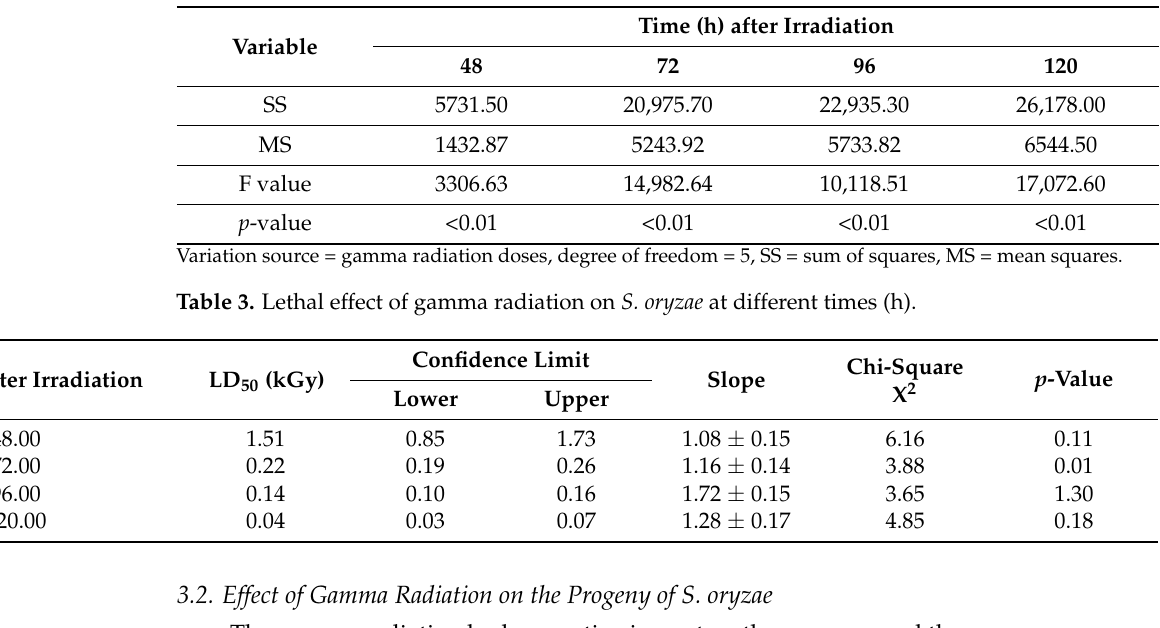
Values are the mean ± S.E. The means of each column followed by the different letters are significantly different at 0.05 level according to Tukey’s multiple range test. Table 2. Analysis of variance of mortality percentage of S. oryzae after exposure to different doses of gamma radiation at different times.